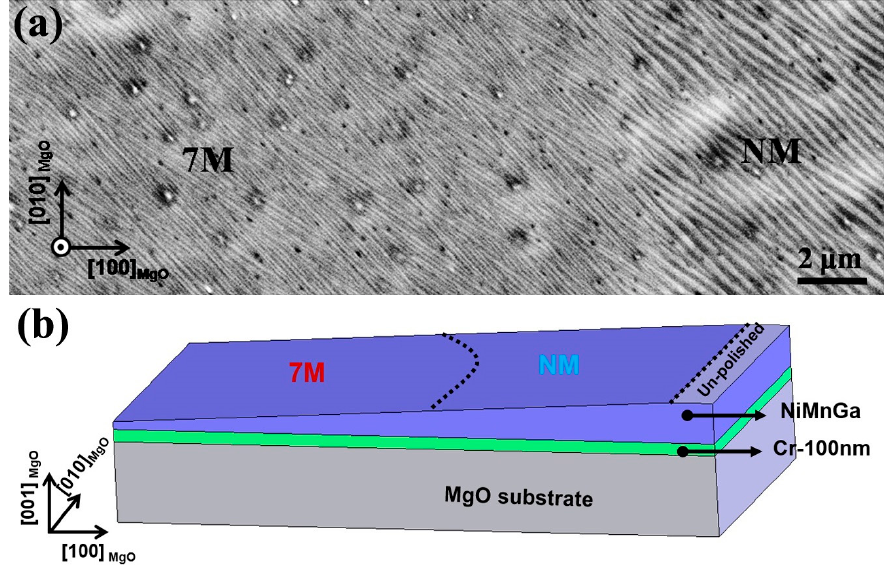
Figure 11. ( a ) Microstructure of electrolytically polished Ni 50 Mn 30 Ga 20 thin film with gradient thickness relative to the film surface; and ( b ) schematic illustration of the sample thickness change from the left side to the right side [62].